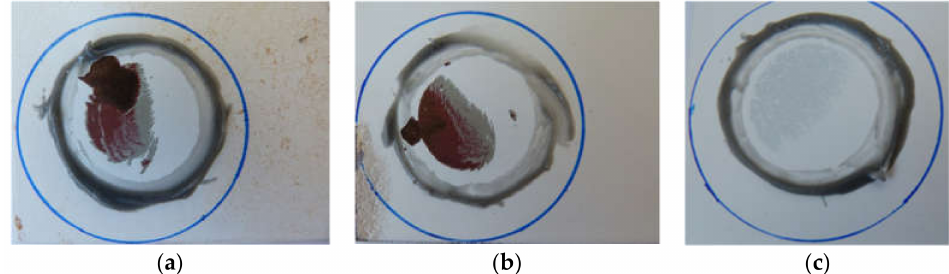
Figure 14. Appearance of the surface affected by the adhesion test area performed after the damp heat test, for ( a ) the sample with sand from Ouarzazate, ( b ) the sample with sand from Dubai, and ( c ) the sample without sand.